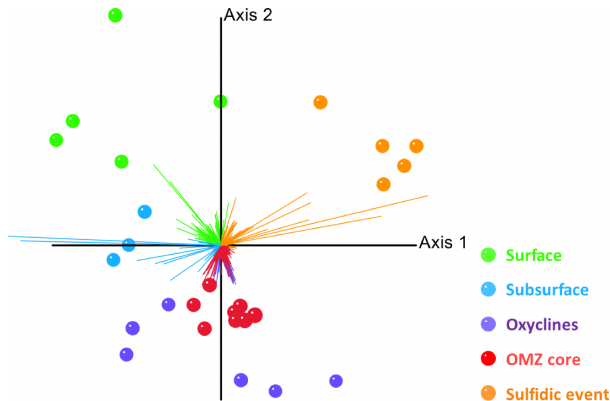
Figure 4. Redundancy analysis ordination model of microbial taxa (vectors) identified from pyrosequencing reads of multiple samples (points) in the ETSP. Spherical k -means clustering revealed a 5- fold partitioning that reflects distinct OMZ habitats (see legend). Each point is colored according to the cluster that dominated the microbial population in the respective